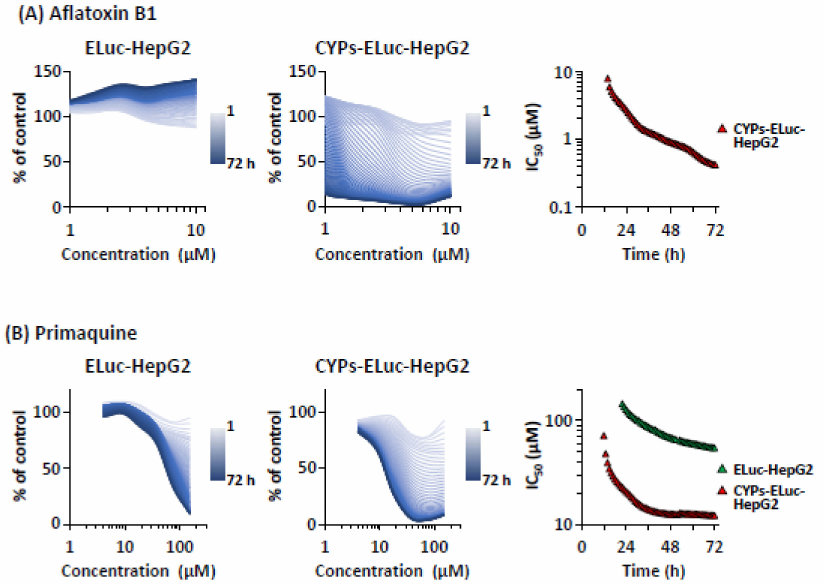
Figure 6. Concentration-response curves and time-dependent changes of IC 50 values for aflatoxin B1- or primaquine-treated ELuc-HepG2 and CYPs-ELuc-HepG2 cells. Concentration-response curves at 1-h intervals were constructed using real-time bioluminescence measurement data shown in Figure 5 for aflatoxin B1- ( A ) or primaquine- ( B ) treated ELuc-HepG2 cells (left panels) and CYPs-ELuc-HepG2 cells (middle panels). Data are expressed as percentage of vehicle control cells (set at 100%) at each time point. IC 50 values were calculated from the concentration-response curves at each time